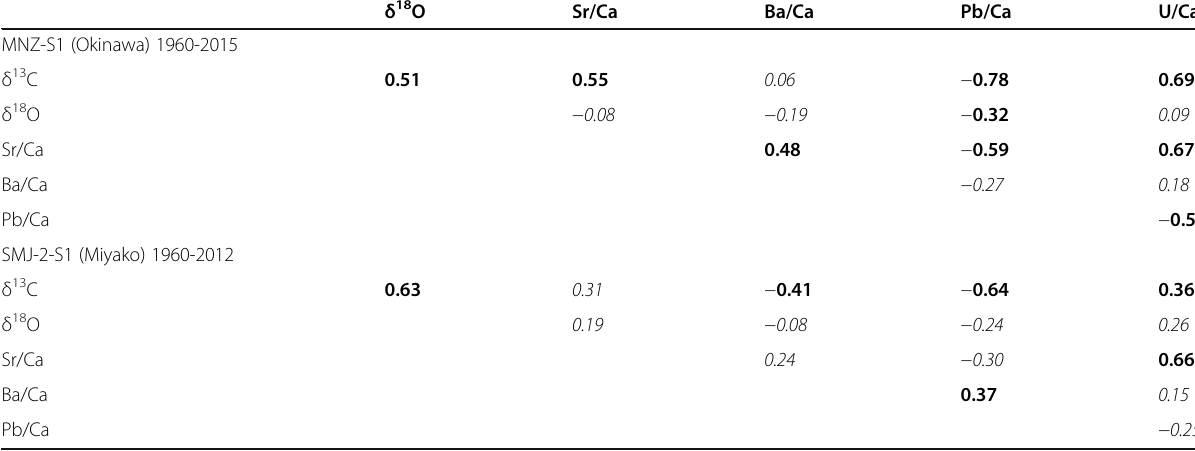
Table 3 Correlations between sclerosponge geochemical records